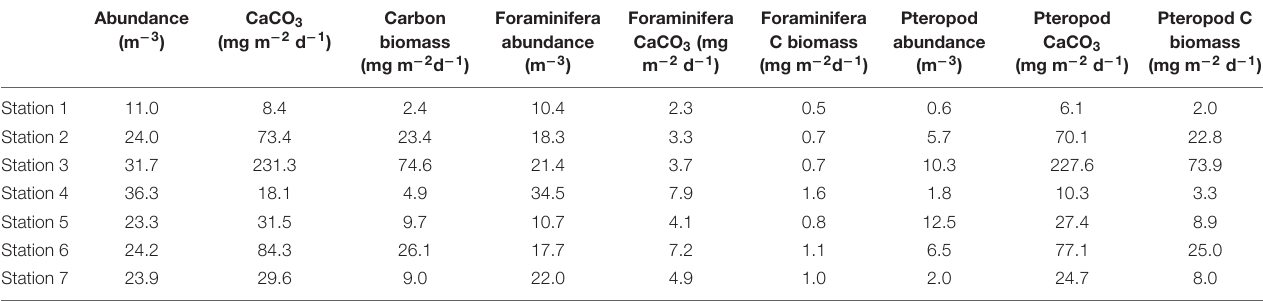
TABLE 6 | Absolute abundance (m − 3 ) from 50 to 100 m and derived CaCO 3 export production (mg m − 2 d − 1 ) and carbon biomass (mg m − 2 d − 1 ) and the contribution from planktic foraminifera and pteropods. Abundance (m − 3